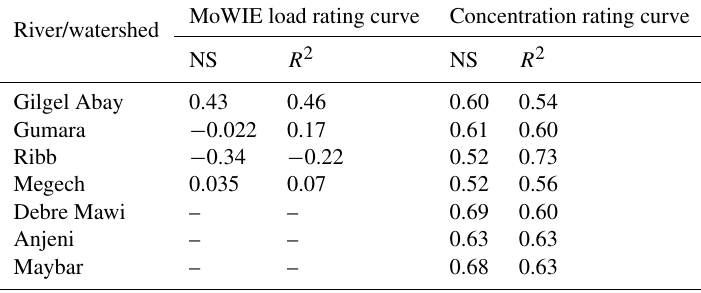
Table 3. Performance of sediment concentration predicted by MoWIE load rating curve and the concentration rating curve. River/watershed